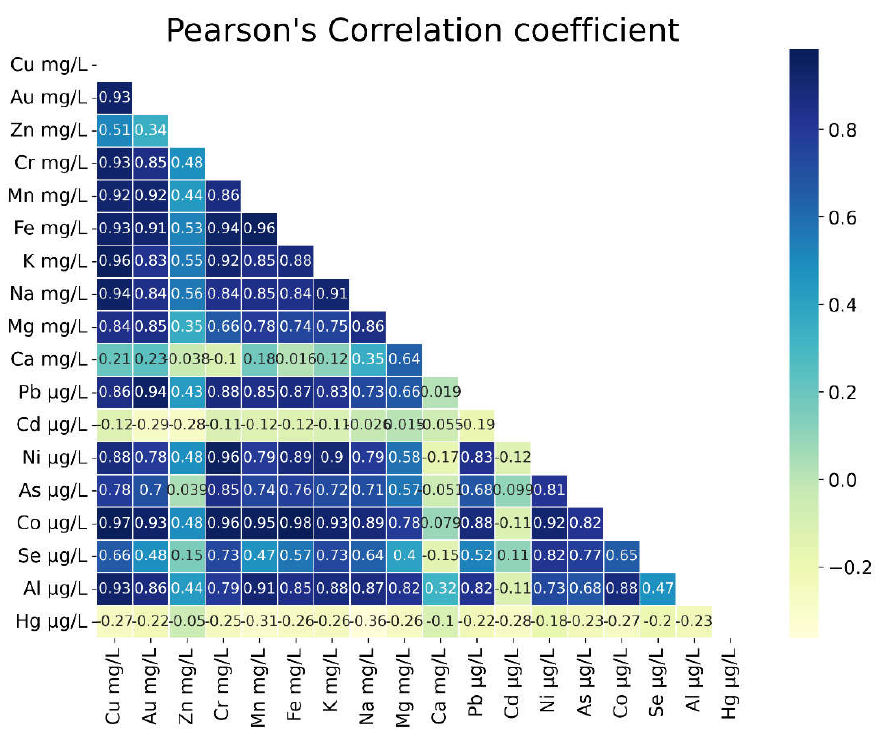
Figure 8. Pearson correlation coefficients.